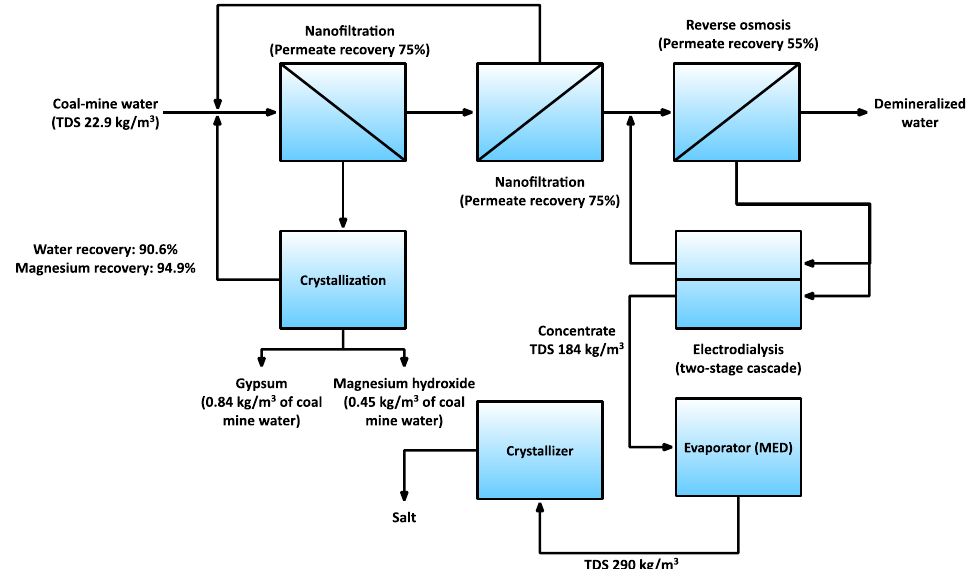
Figure 5. An overview of the ZERO BRINE technology for coal mine water treatment